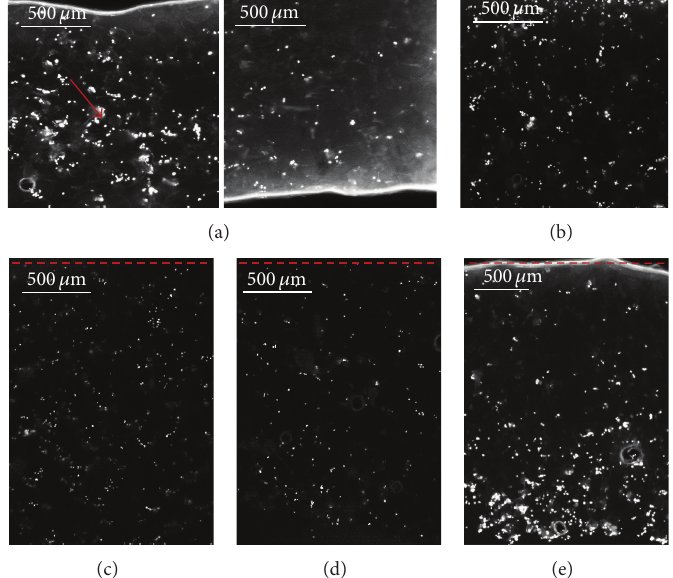
Figure 5: Representative fluorescence microscopy images of MC3T3-E1 cell nuclei stained with DAPI. Longitudinal sections of injection ((a) upper region on the left and lower region on the right), dropwise-seeded scaffolds (b) and perfusion-seeded scaffolds ((c) flow rate 0.03 mL/min, (d) flow rate 0.1mL/min and (e) flow rate 0.3 mL/min). The red arrow indicates the injection area, and the red dashed lines represents the seeding